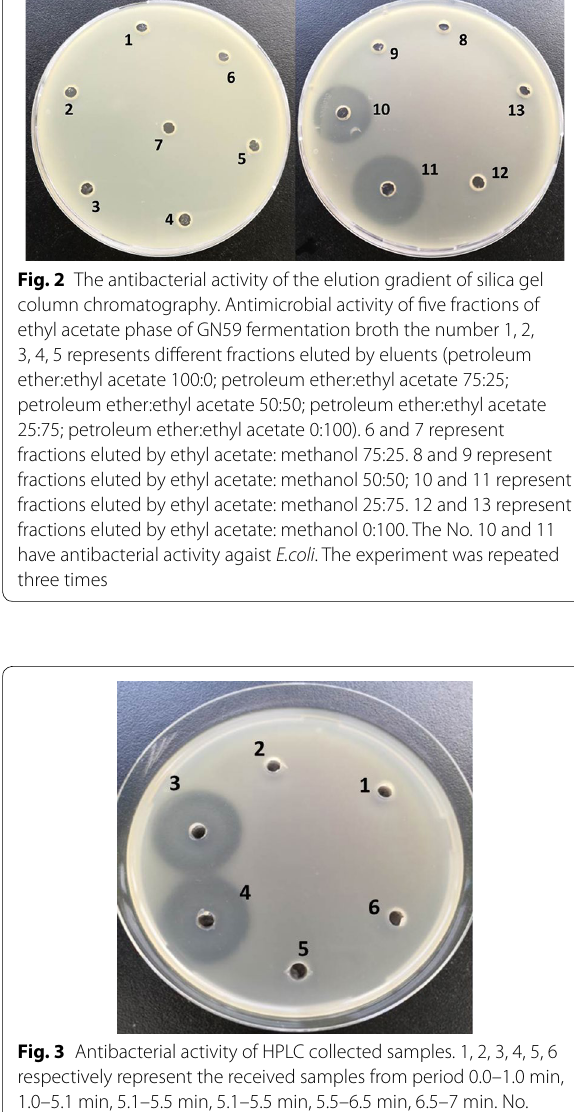
m/z 342.1402 [M H] + (Additional file 1: Fig. S3). The + chemical formula of the compound is C 12 H 23 NO 10 after analysis (Fig. 4) which is the same with the substance 34.